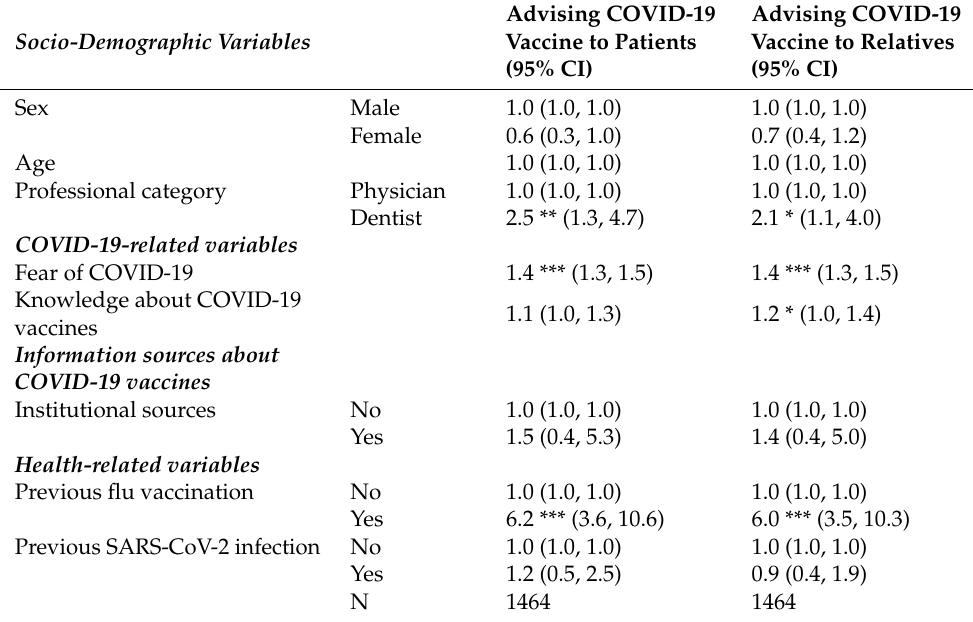
Table 7. Multivariable logistic analysis: physicians and